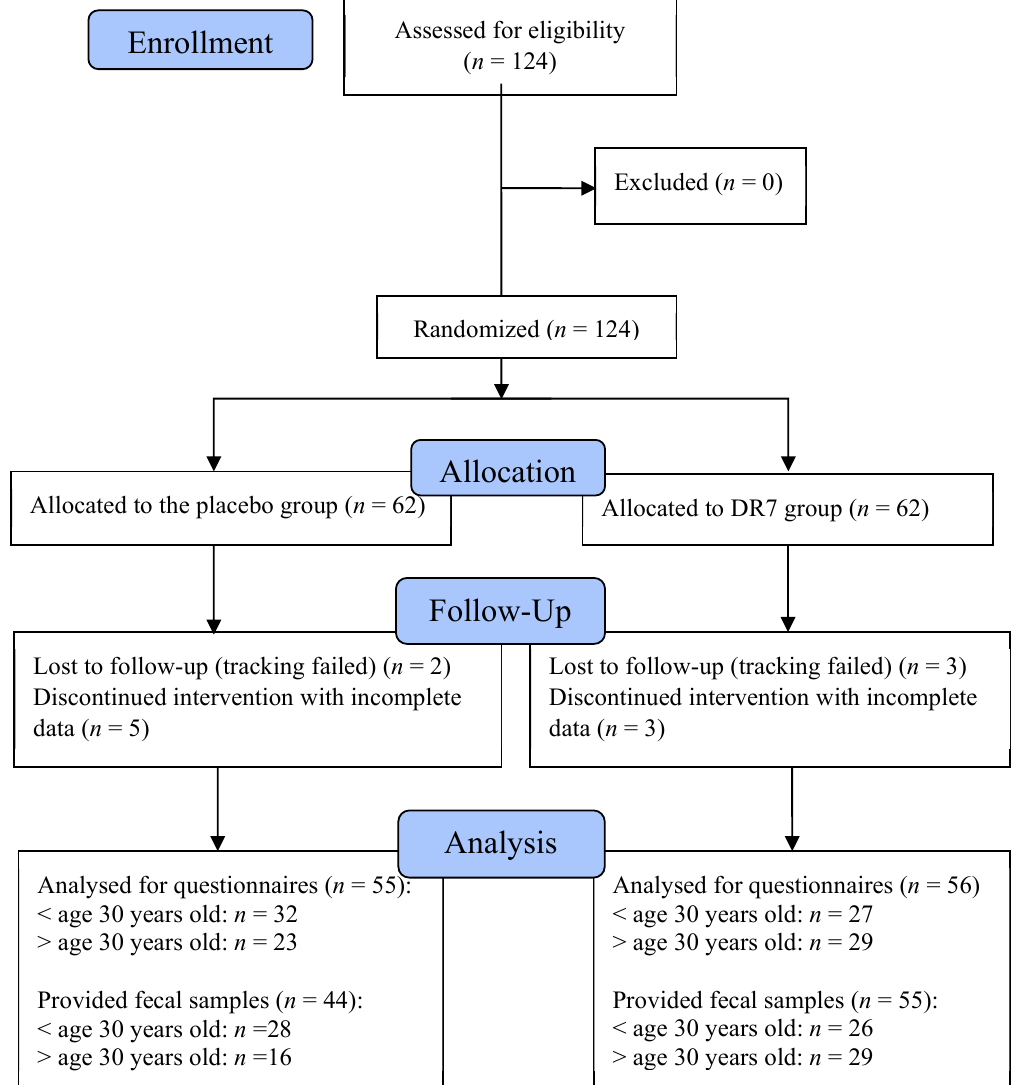
Figure 1. Consort flow chart of recruitment for both intervention groups.